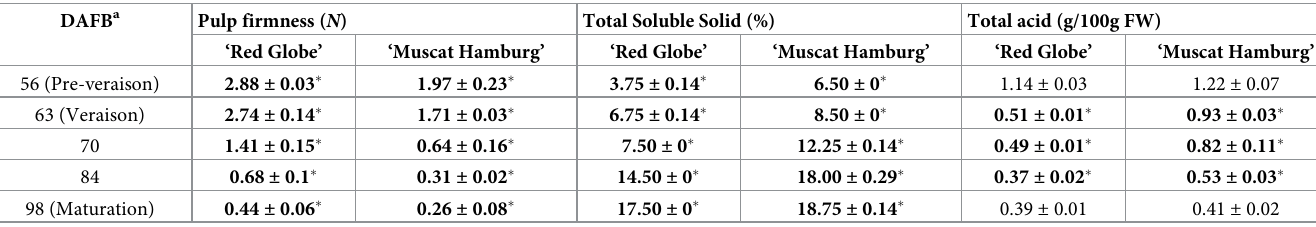
Table 1. Variations of pulp firmness, total soluble solid and total acid in ‘Red Globe’ and ‘Muscat Hamburg’. DAFB